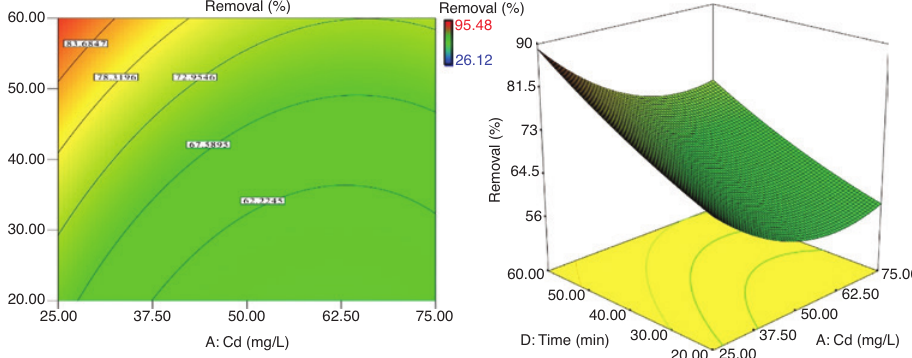
Figure 6: The contour and three-dimensional diagrams of Cd removal efficiency (%) as a function of initial Cd concentration and contact time.